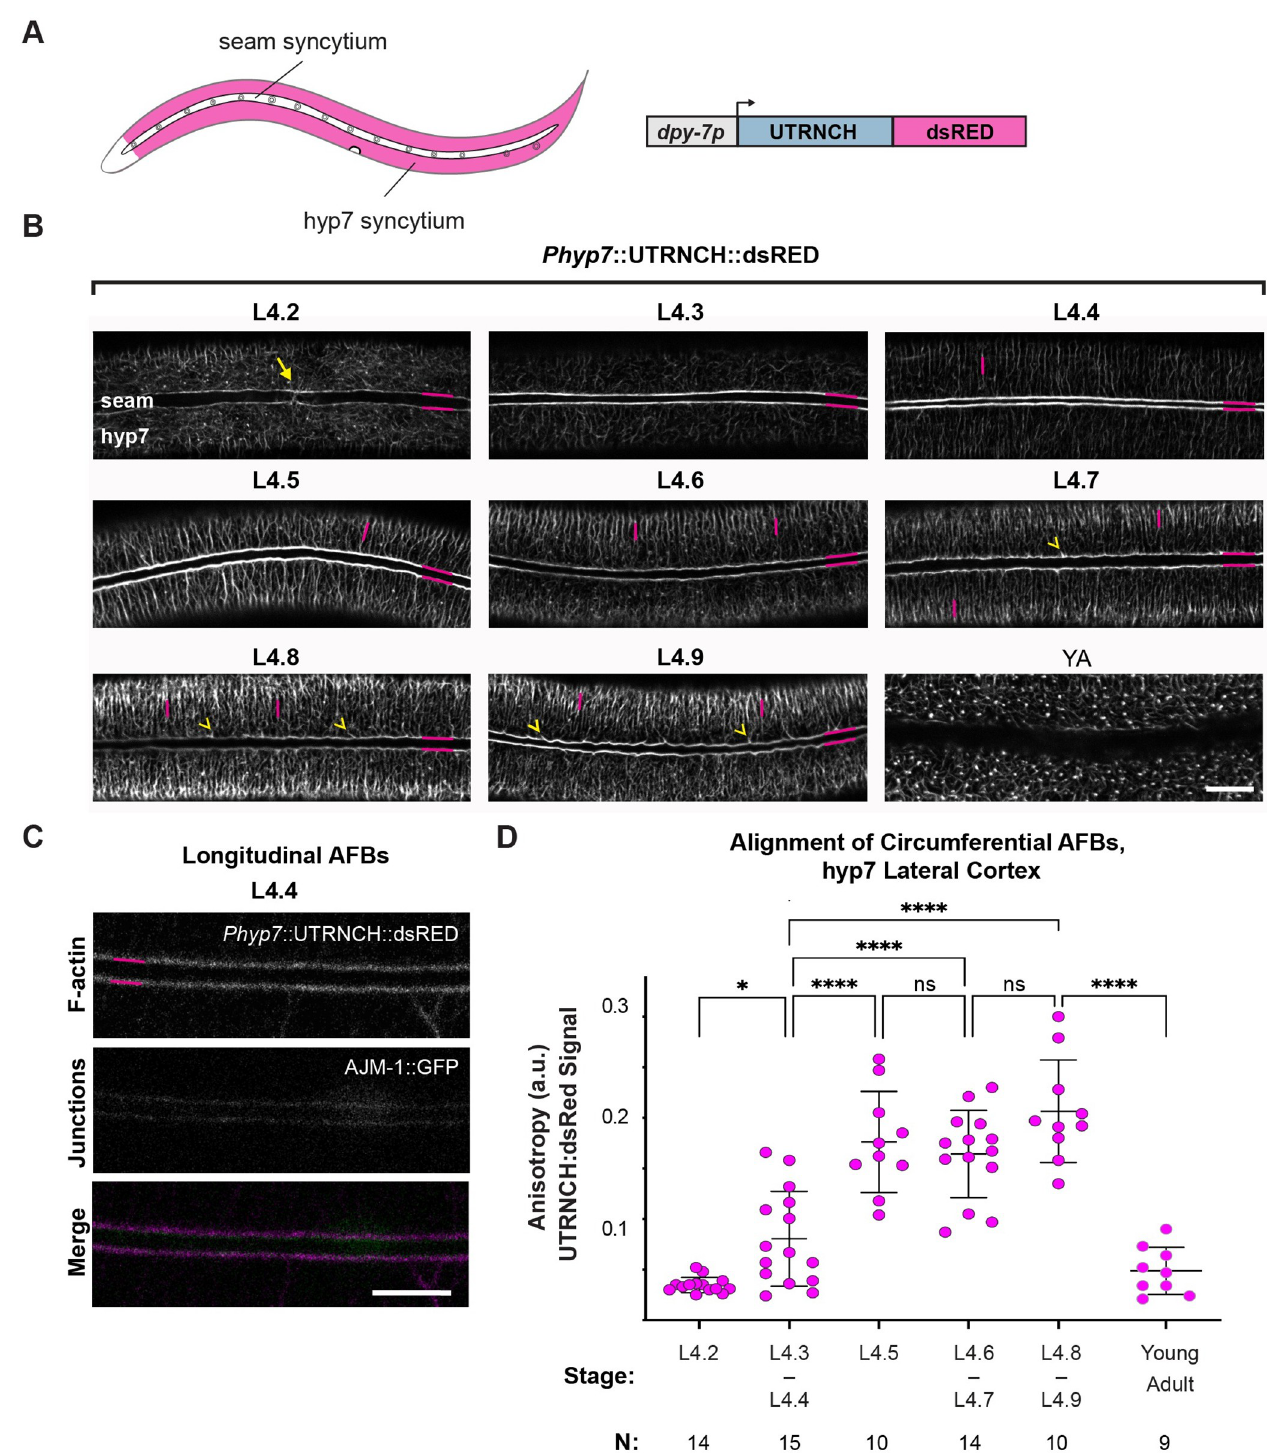
Fig 4. Longitudinal AFBs assemble in hyp7 as the seam narrows, whereas circumferential AFBs form parallel arrays as the seam widens. (A) Diagram as in Fig 3A except hyp7 is magenta while seam is white. The hyp7-specific promoter dpy-7p was used to drive UTRNCH::dsRED expression. (B) Inverted confocal fluorescence micrographs show UTRNCH::dsRED detected at the indicated stages (strain ARF385, 25˚C). L4.2: Arrow indicates F-actin at a presumptive seam-seam junction before fusion. Horizontal magenta lines label longitudinal AFBs along the lateral margins. Vertical magenta lines label circumferential AFBs (CFBs). Images are representative of n = 9 or more animals per stage. Scale bar, 10 μ m. (C) Longitudinal AFBs in hyp7 overlap with AJs. (D) Quantitation of cortical CFB alignment in lateral (thick) region of hyp7. Values are averages of 6 ROIs per worm. ���� P � 0.0001, � P � 0.01, Anova with Tukey’s correction for multiple